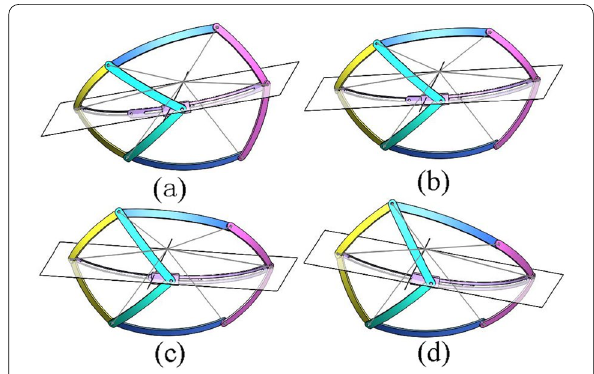
Figure 8 Numerical example of the equivalent